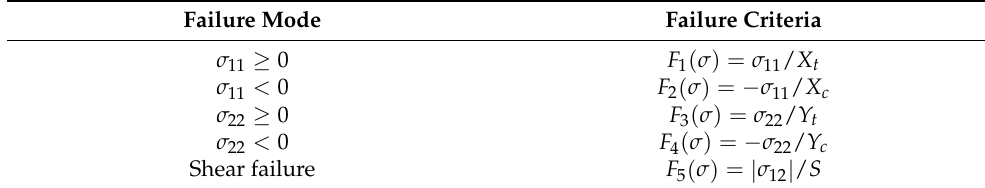
Table 6. Multi-component 2D failure criteria.